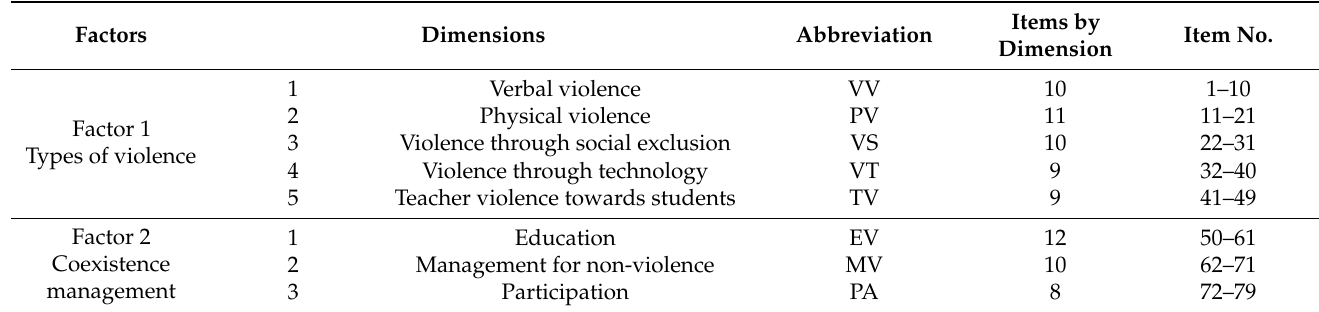
Table 3. Structure of CENVI questionnaire. Source: Muñoz et al. [4].